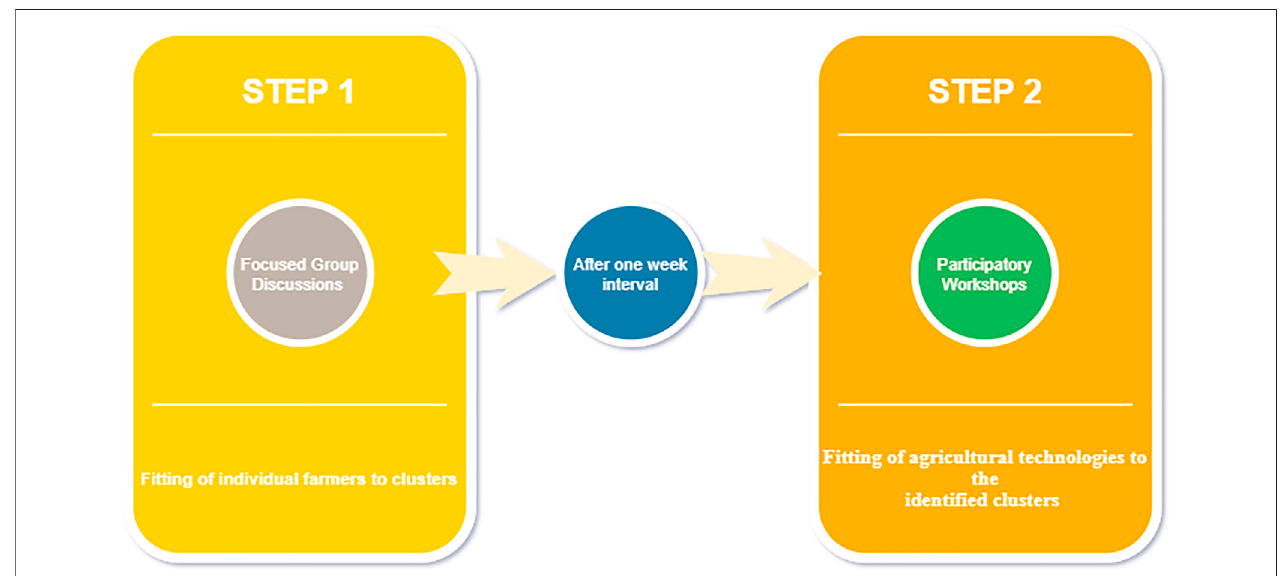
FIGURE 5 | Steps followed in the qualitative analysis for validation and fi tting the technology.